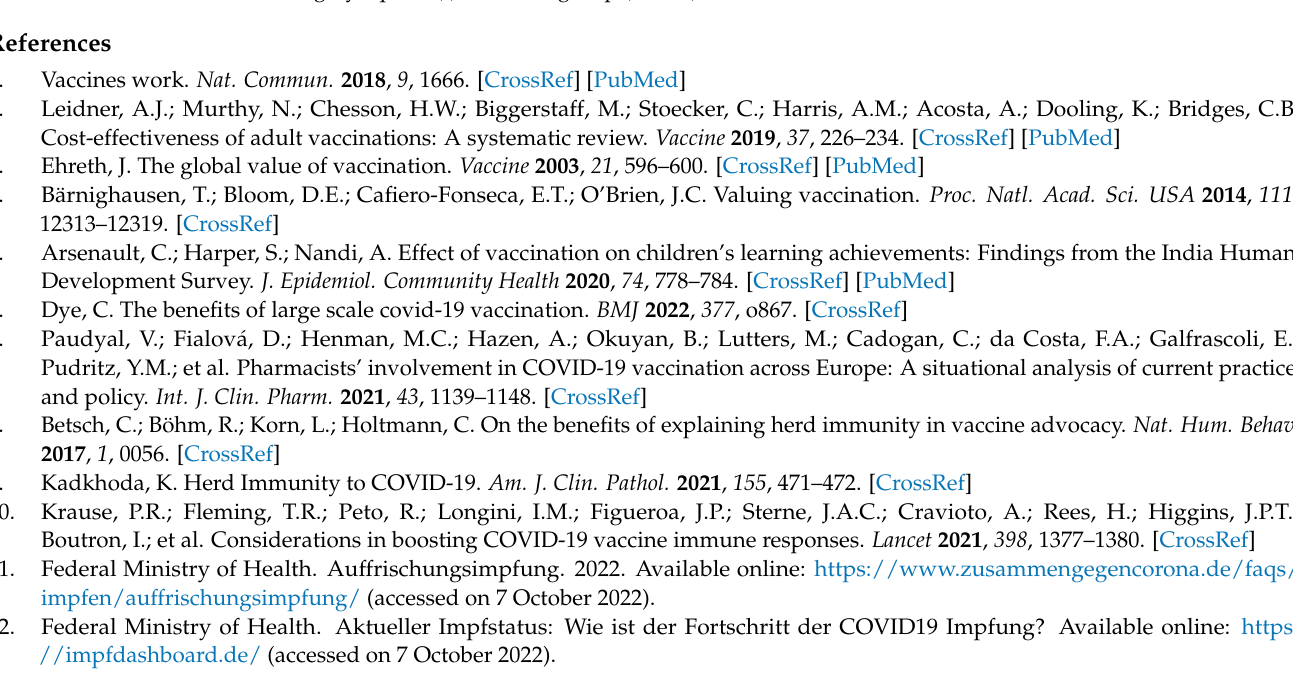
Figure A1. Forest Plot of mean values with 95% confidence interval of self-assessment scores for question 7 to 9 in post-Training (6-point Likert scale). White dots ( ○ ) = intervention group (n = 20); grey square ( ▪ ) = control group (n = 21).